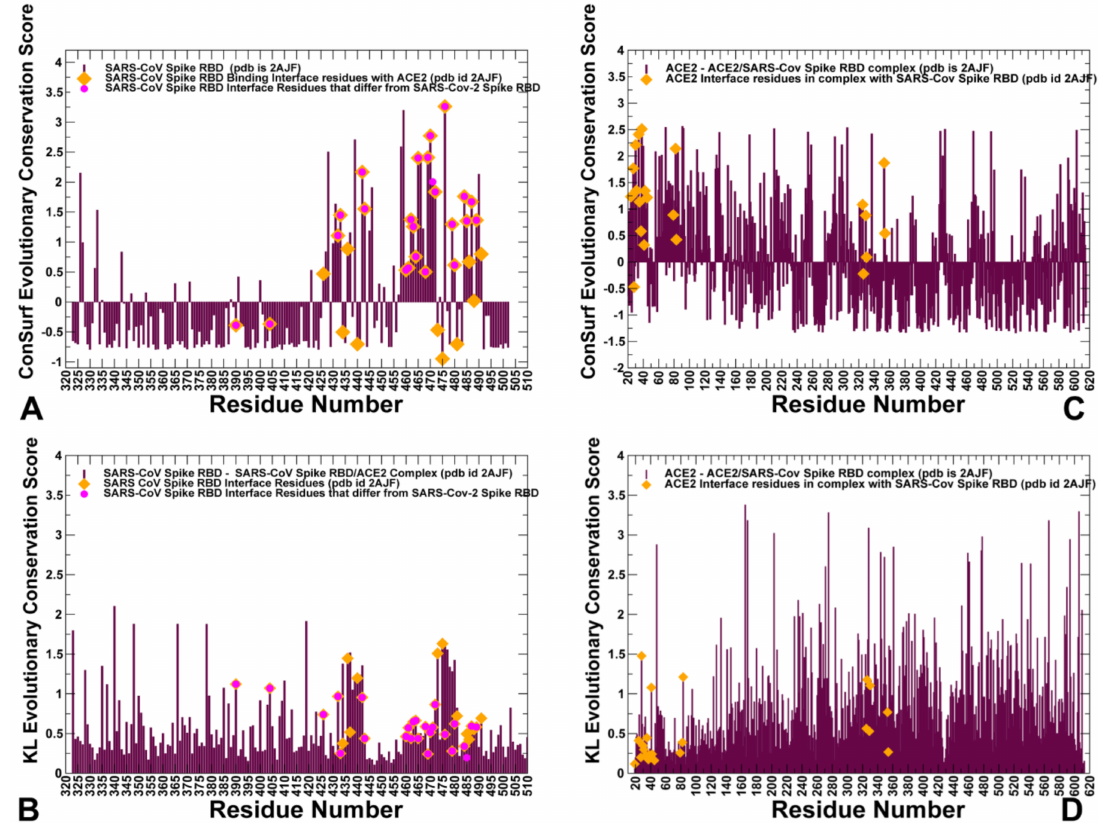
Figure 4. Sequence conservation profiles of the SARS CoV and ACE2 proteins. ( A ) The normalized ConSurf conservation scores for SARS-CoV-RBD spike protein are projected onto the SARS-CoV-RBD complex with ACE2 (residue numbering as in pdb id 2AJF). The ConSurf profiles are shown in maroon bars. The negative ConSurf scores correspond to highly conserved sites (with ConSurf score < 0), and high positive scores (Consurf score > 1.0) depict highly variable positions. Consurf score = 1.0 is defined as a threshold for di ff erentiating moderately and highly variable positions. The binding interface residues with ACE2 are highlighted in orange filled diamonds. The position of the binding interface residues that di ff er between SARS-CoV-RBD and SARS-CoV-2-RBD are shown in smaller magenta filled circles. ( B ) The KL conservation score for SARS-CoV-RBD spike protein. High KL scores indicate highly conserved sites (above threshold of KL = 1.0) and low scores correspond to more variable positions. The annotation of the binding interface residues is as in panel A. ( C ) The normalized ConSurf conservation scores for ACE2 residues (residue numbering corresponds to ACE2 structure in complexes with SARS-CoV (pdb id 2AJF) and SARS-CoV-2 (pdb id 6M0J). The ACE2 binding interface residues are highlighted in orange filled diamonds. ( D ) The KL conservation score for ACE2 residues. The ACE2 binding interface residues are highlighted in orange filled